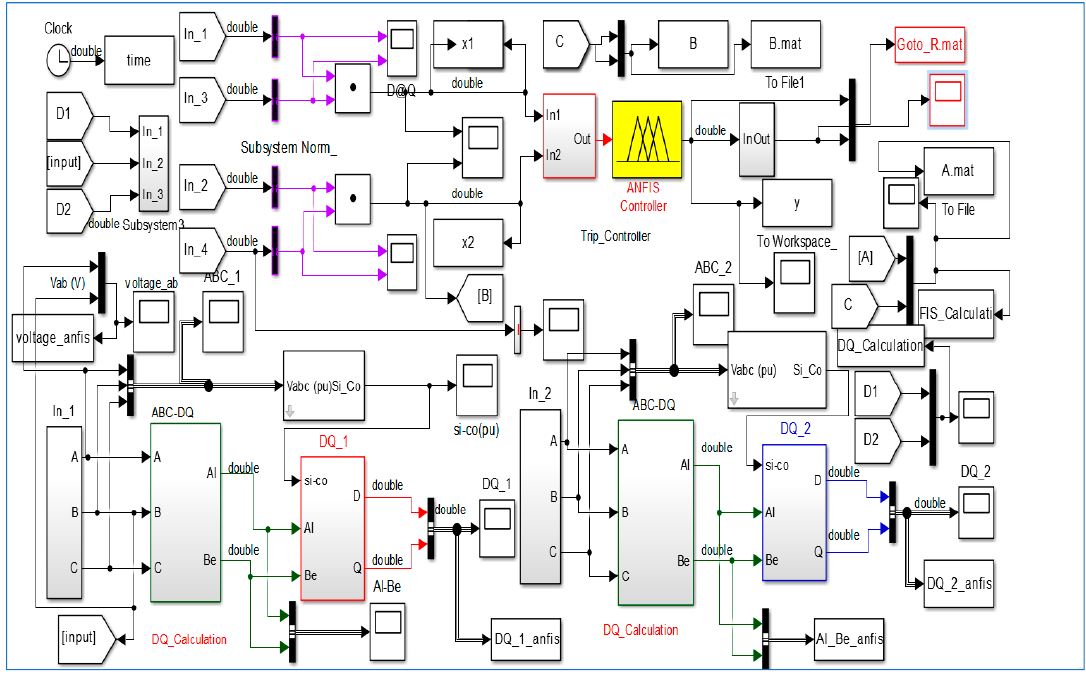
Figure 3. Implementation of decision maker (HSBP—ANFIS).